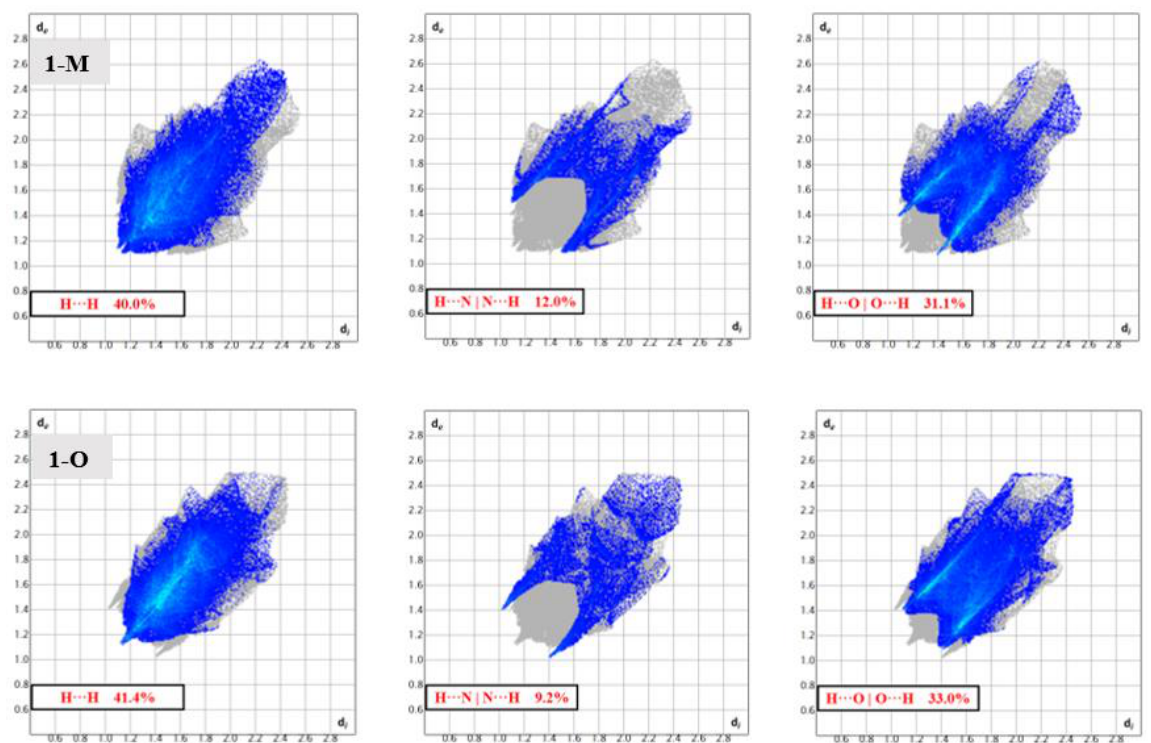
Figure 7. Fingerprints depicting the ‘spikes’ arising from H ··· H, H ··· N, and H ··· O interactions in 1-M and 1-O . The differing shapes of these regions of interactions depict the distinct interactions in the polymorphs.